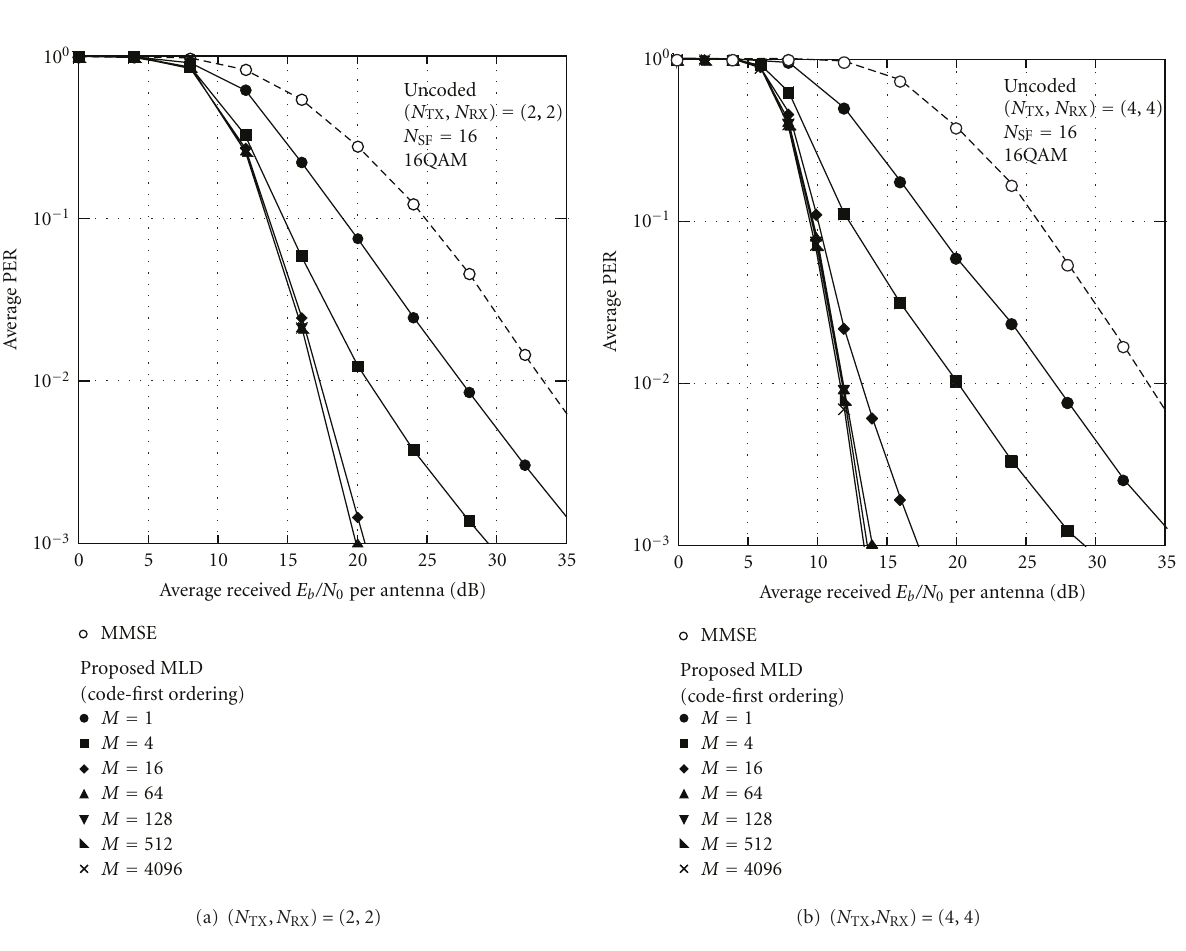
Figure 5: Average PER as a function of average received E b /N 0 (uncoded